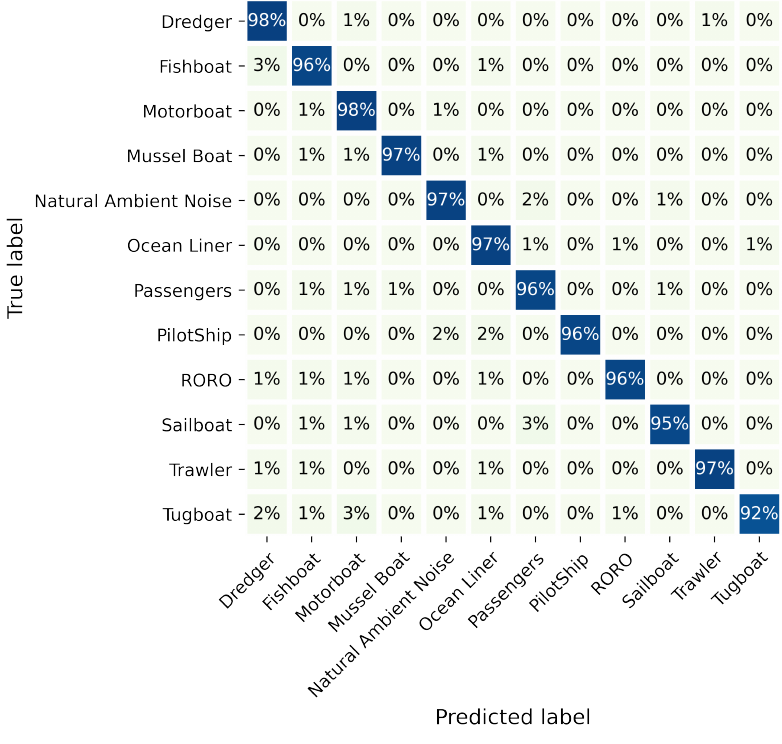
Figure 10. Ship type classification